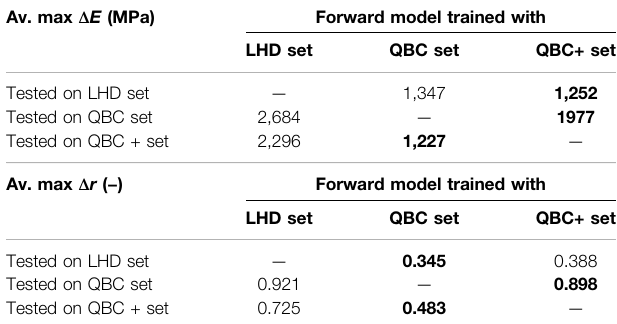
TABLE 3 | Average maximum Δ E and Δ r for the neural networks trained and evaluated on the three generated data sets: LHD (Latin hypercube design), QBC (query-by-committee) and QBC+ (query-by-committee with extension). The best result for each test set is marked in